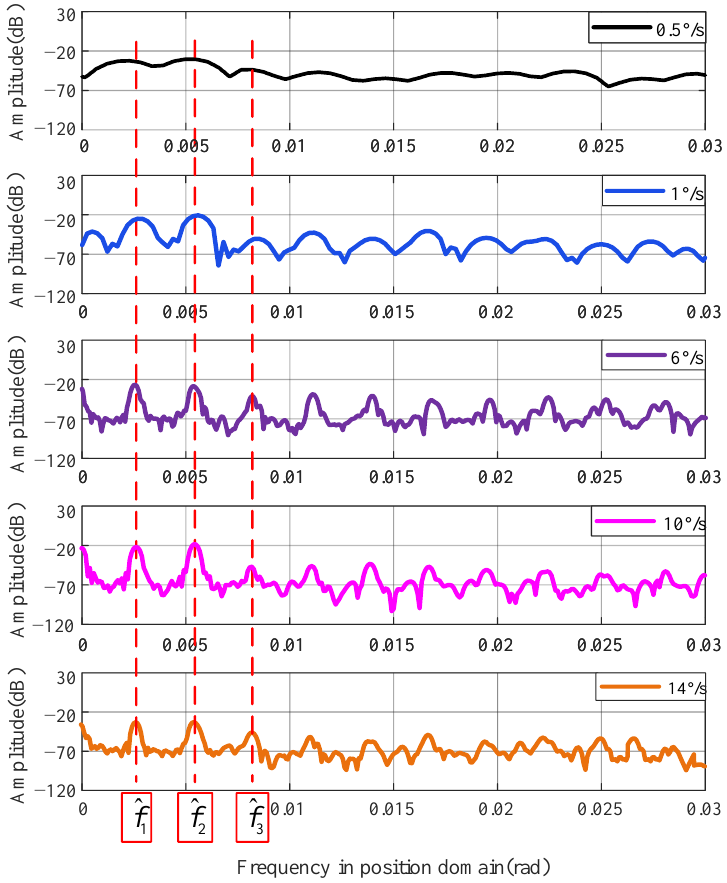
Figure 6. The position domain spectrogram of kinematic